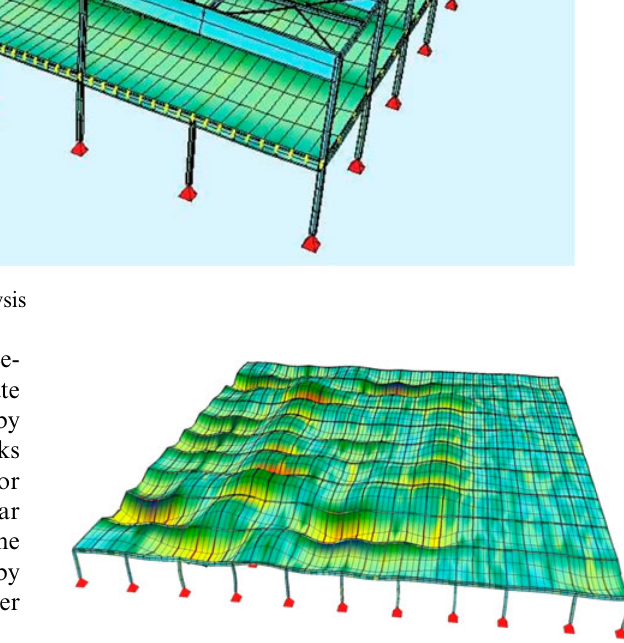
Fig. 19. Example of the results of dynamic calculations for eigenvalue 6.56 Hz